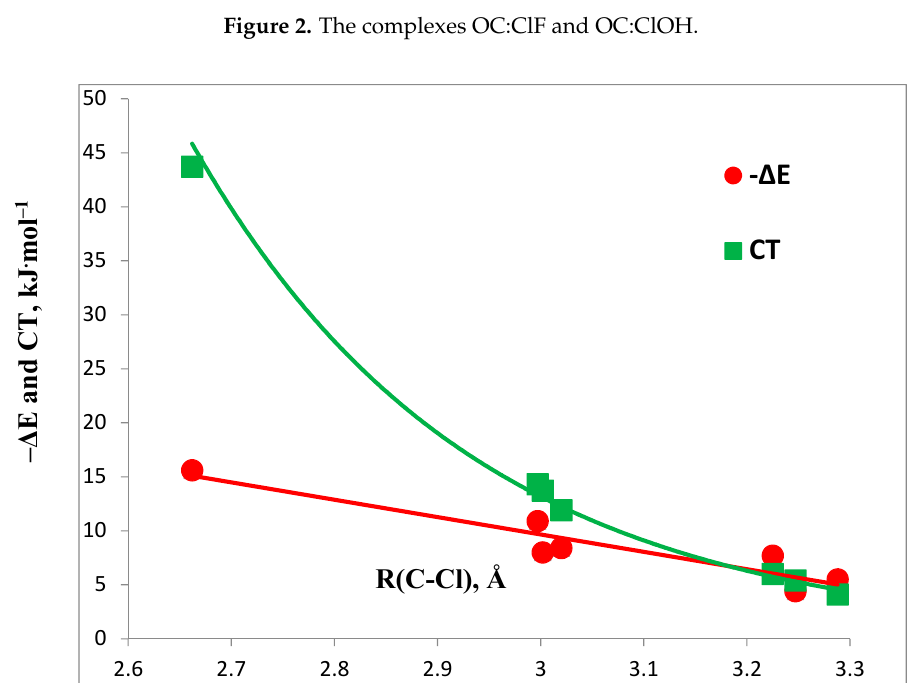
Figure 3. Binding energies and charge-transfer energies versus the C–Cl distance in complexes OC:ClY.